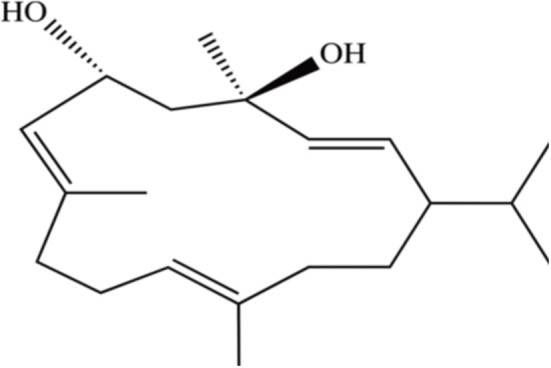
The structure of 4R.